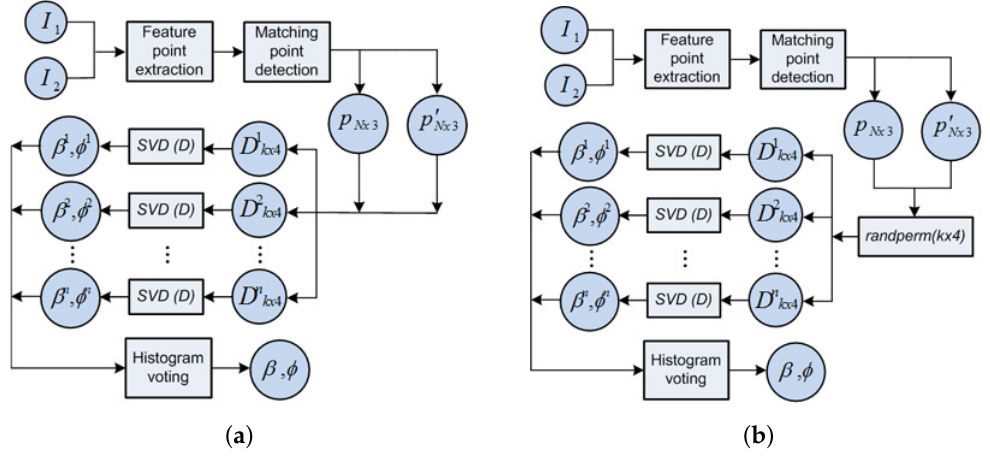
Figure 15. Block diagrams for the proposed solver variants: ( a ) Solver 2; ( b ) Solver